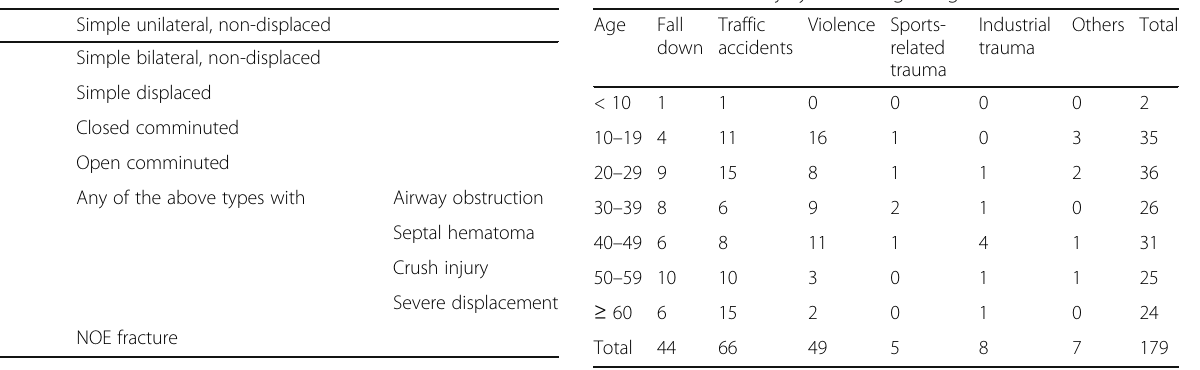
Table 1 Classification of nasal bone fracture